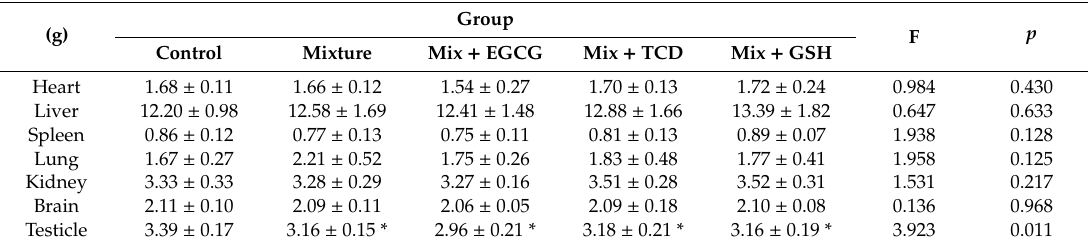
Table 2. E ff ects of the heavy metal mixture on the organ weights with or without the addition of chemical antagonists in SD rats ( n = 30).